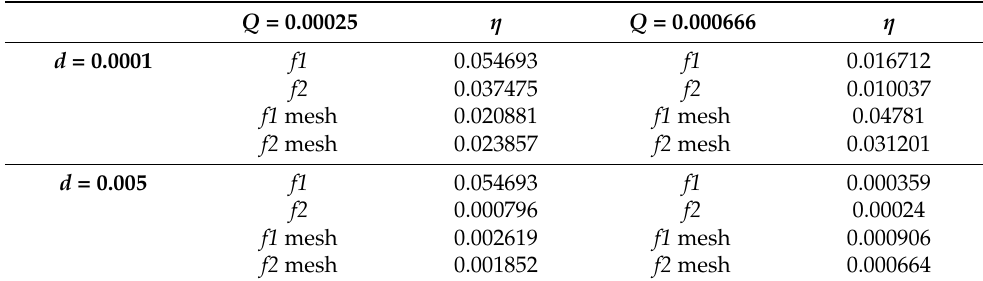
Figure 11. Atomization efficiency η , d = 100 µm: ( a ) Q = 0.00025 m 3 /s; ( b ) Q = 0.000666 m 3 /s. Table 3. The average atomization efficiencies η .